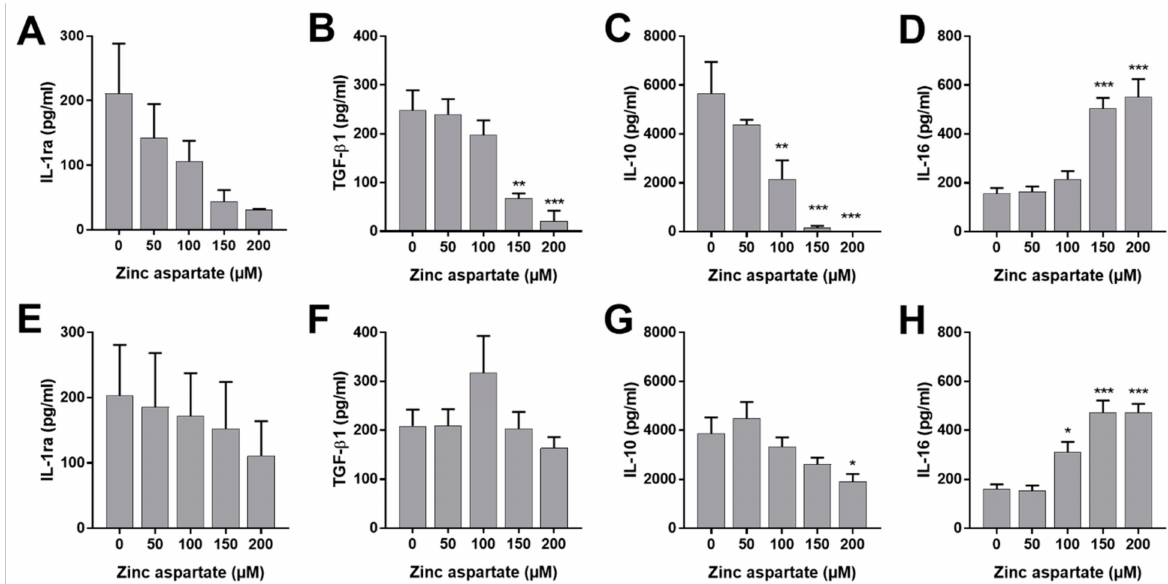
Figure 2. Zinc aspartate enhanced secretion of IL-16 from stimulated human T cells. Human T cells freshly stimulated ( A – D ) or pre-activated ( E – H ) with anti-CD3/CD28 antibodies were incubated in the presence or absence of different concentrations of zinc aspartate. Cell culture supernatants were harvested after 72 h of incubation. Cytokine concentrations were determined with specific ELISA. Data are given as mean + SEM of four independent experiments. (* p < 0.05, ** p < 0.01, *** p <